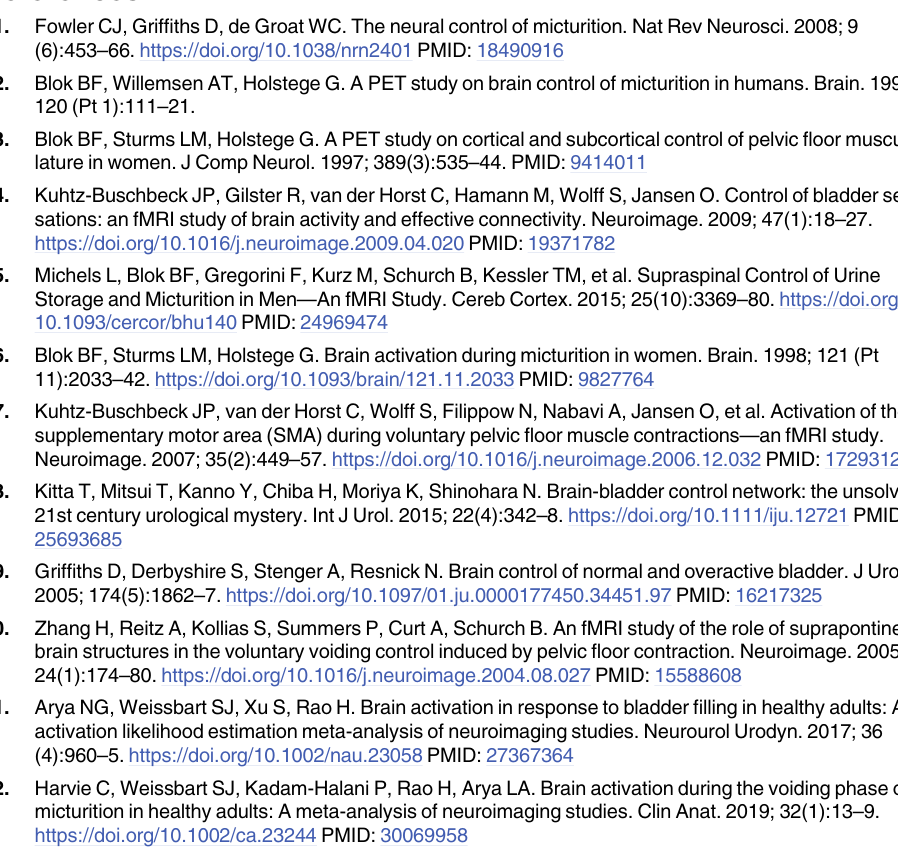
S4 Table. Peak coordinates of clusters with task specific activity (pelvic floor muscle con- traction), not shown in supplement